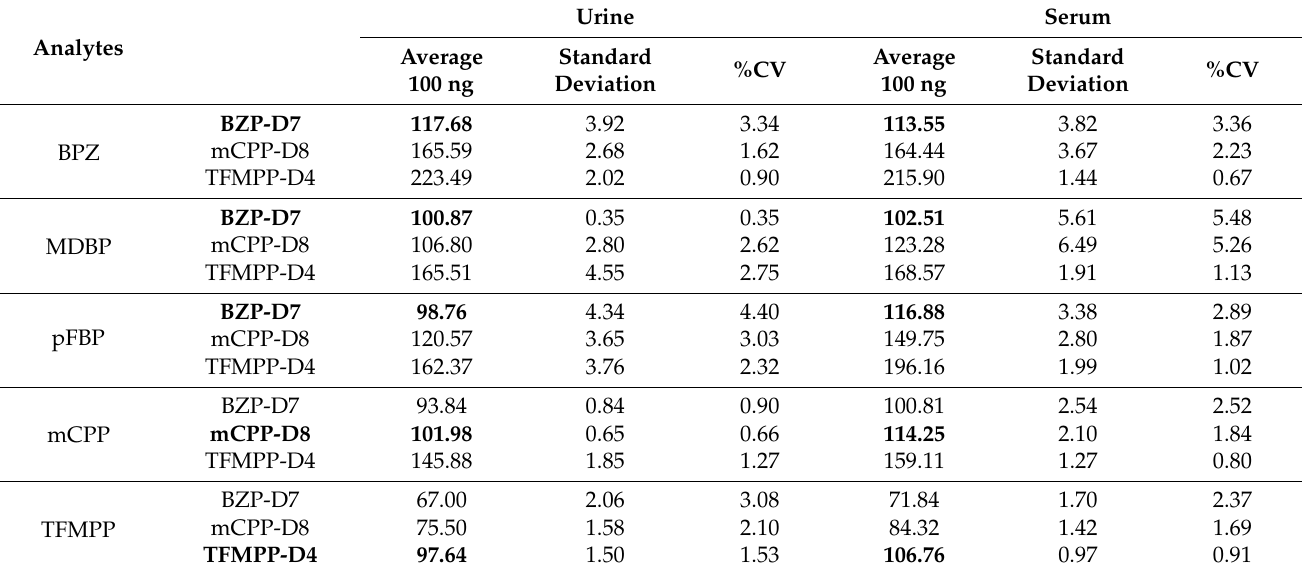
Table 4. Results obtained from the analysis of biological material (urine, serum).